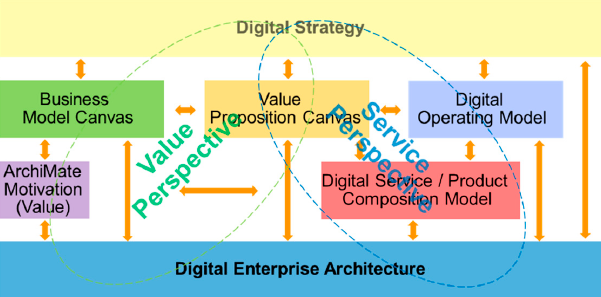
Figure 4. Integral value and service perspective of smart digital services.